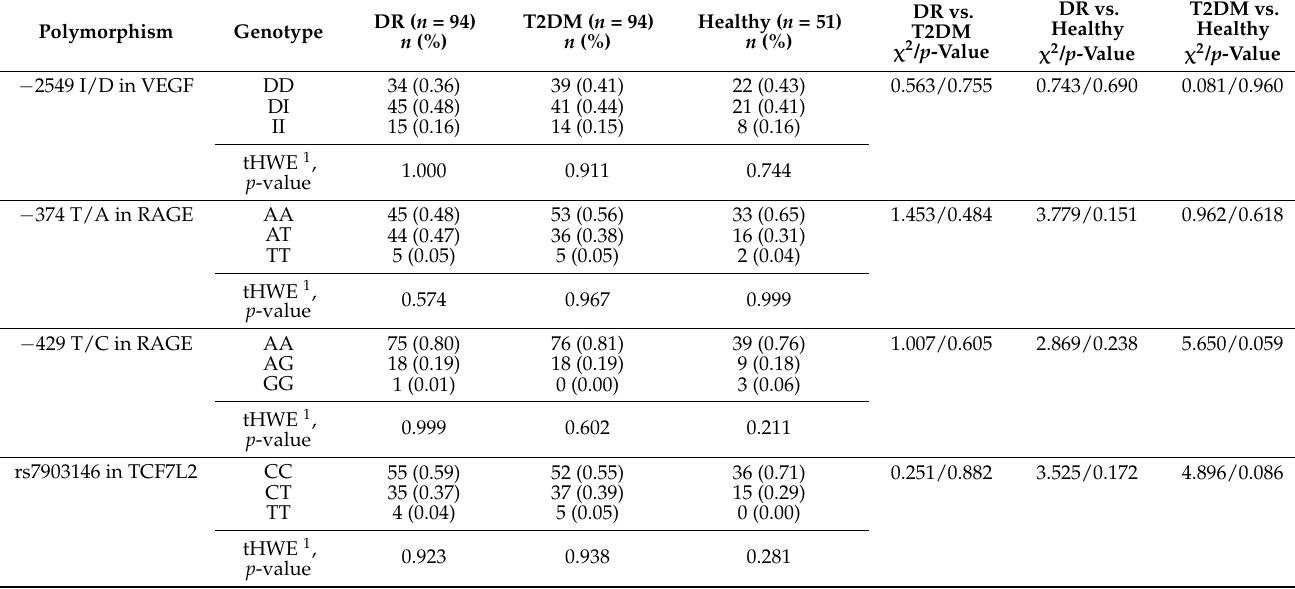
Table 2. Genotype distribution of the studied